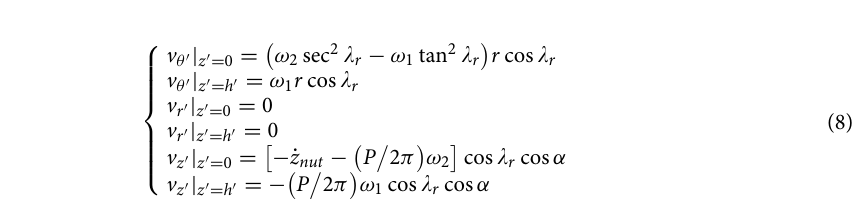
Figure 7. Oil film flow state of hydrostatic lead screw considering oil film slip (a) the circumferential direction (b) the radial